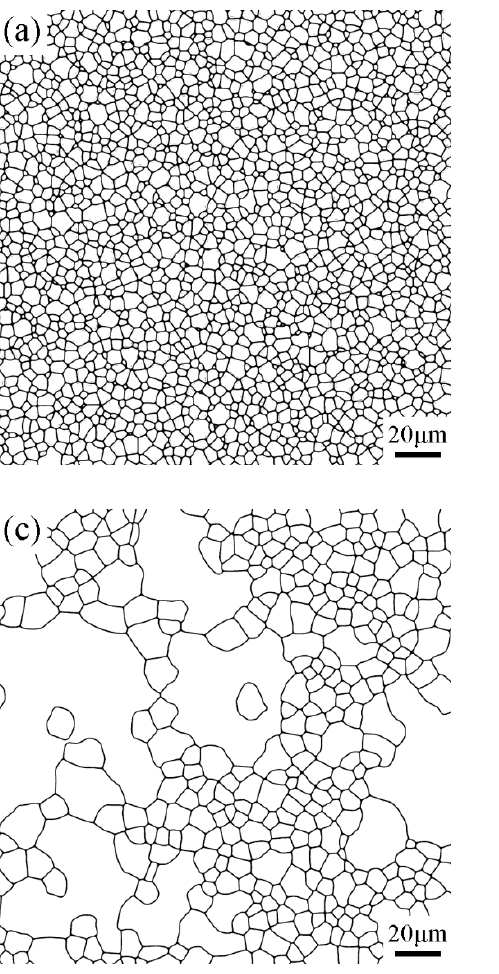
Figure 9. The initial grain structure in MPH simulation ( a ) and the final grain structures after simulated carburization with d 0 of 10 μ m. Images ( b – d ) correspond to the cases of ( b – d ) in Figure 10.